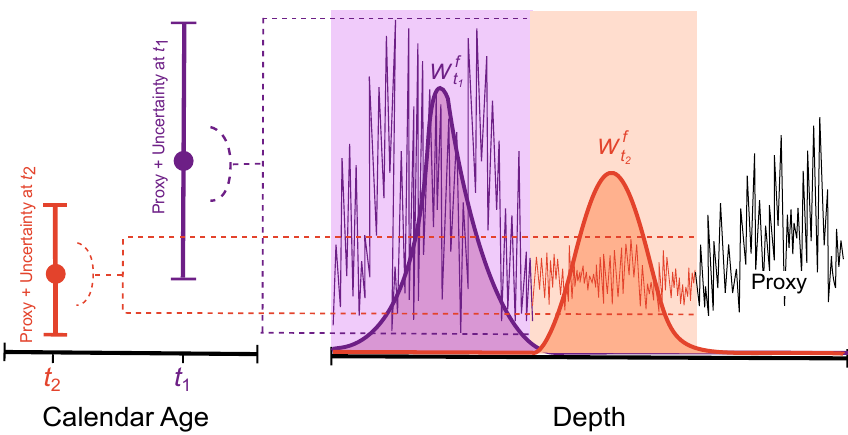
Figure 8. Uncertainty in proxy estimations (schematic). The proxy curve has high variations in region A (purple) and low variations in region B (orange). Two time points t 1 and t 2 are chosen such that their corresponding DWFs cover most parts of regions A and B, respectively. The estimation uncertainty is far greater for the proxy estimate at t 1 than for t 2 because of the corresponding high variability of the proxy in region A. Note: the final uncertainty in the proxy estimate is not equal to the corresponding variability in the depth domain, but is only proportional to it. Hence, we denote the impact of proxy variability over depth (marked with the dashed lines) on the final proxy uncertainty with an open arc. (Color online.)